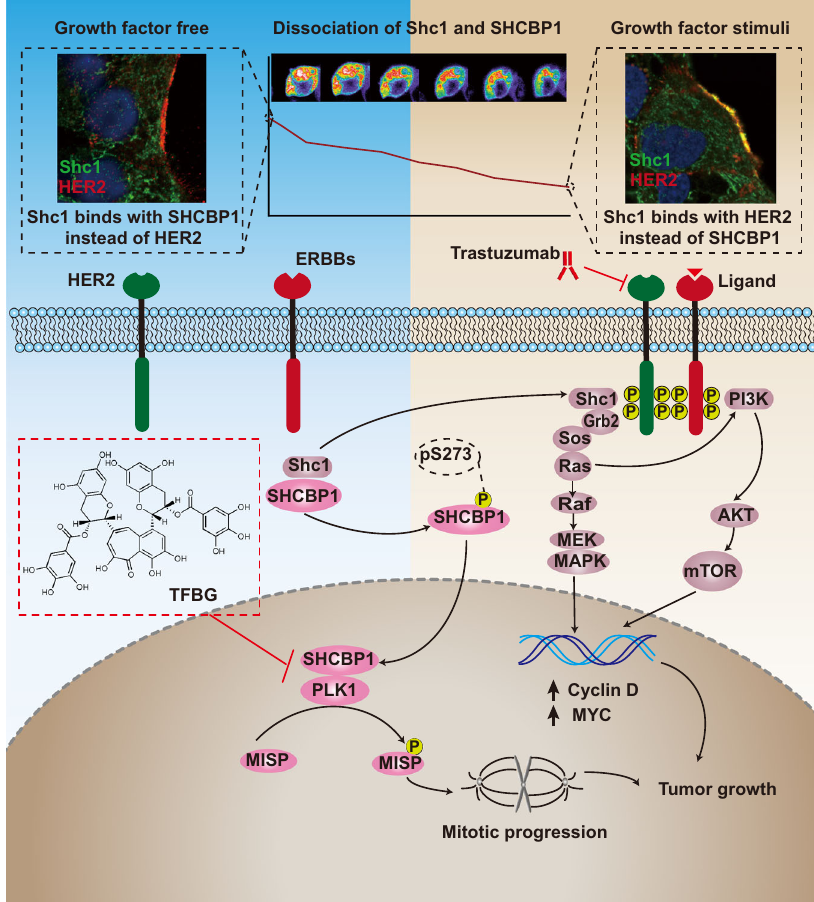
Fig. 8 HER2 promotes tumorigenesis by regulating cell mitotic progression through Shc1 – SHCBP1 – PLK1 – MISP signaling. In growth factor free condition, HER2 is inactivated and SHCBP1 acts as a Shc1-binding protein interacting with Shc1. Following growth factor stimuli, HER2 is activated through dimerization with other HER members and recruits Shc1 to evoke MAPK or PI3K pathways. Released SHCBP1 responds to HER2 cascade by translocating into the nucleus following Ser273 phosphorylation (pS273), and then contributing to cell mitosis regulation through binding with PLK1 to promote the phosphorylation of the mitotic interactor MISP. Hyperactivation of HER2 – SHCBP1 – PLK1 axis impairs the sensitivity of HER2-targeted therapy trastuzumab. The Inhibitor thea fl avine-3, 3 ′ -digallate (TFBG) blocks SHCBP1 – PLK1 complex and renders gastric cancer sensitive to trastuzumab. TFBG – trastuzumab combination is highly ef fi cacious to suppress gastric cancer